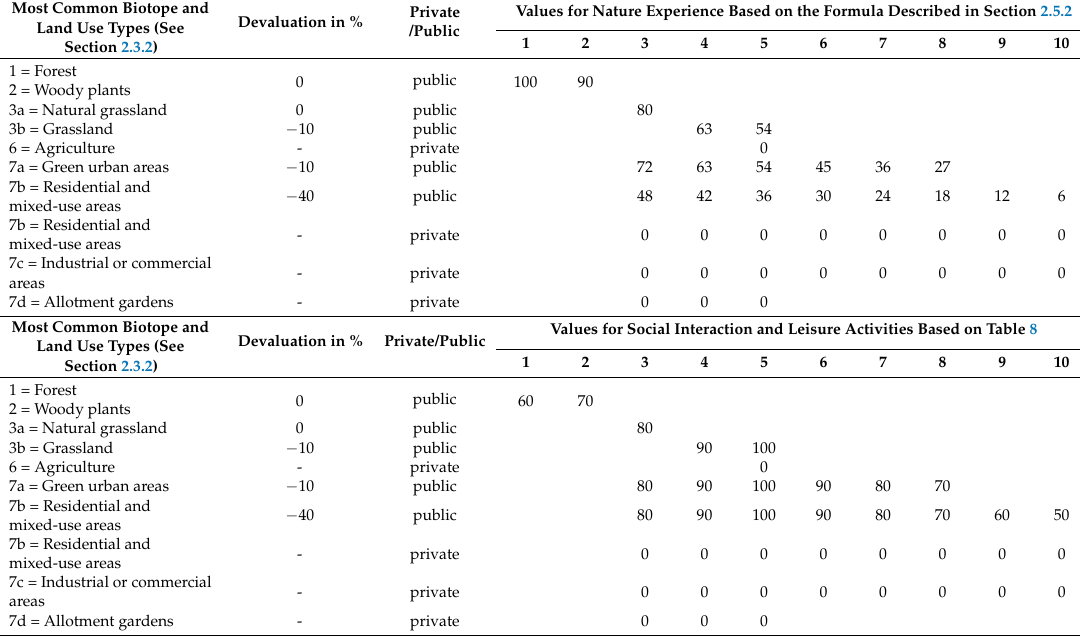
Table 12. Index values for “nature experience” and “social interaction and leisure faculties” for the most common biotope or land use type and each hemeroby degree. Value 100 = highest ecosystem service capacity; 0 = lowest/no ecosystem service capacity.